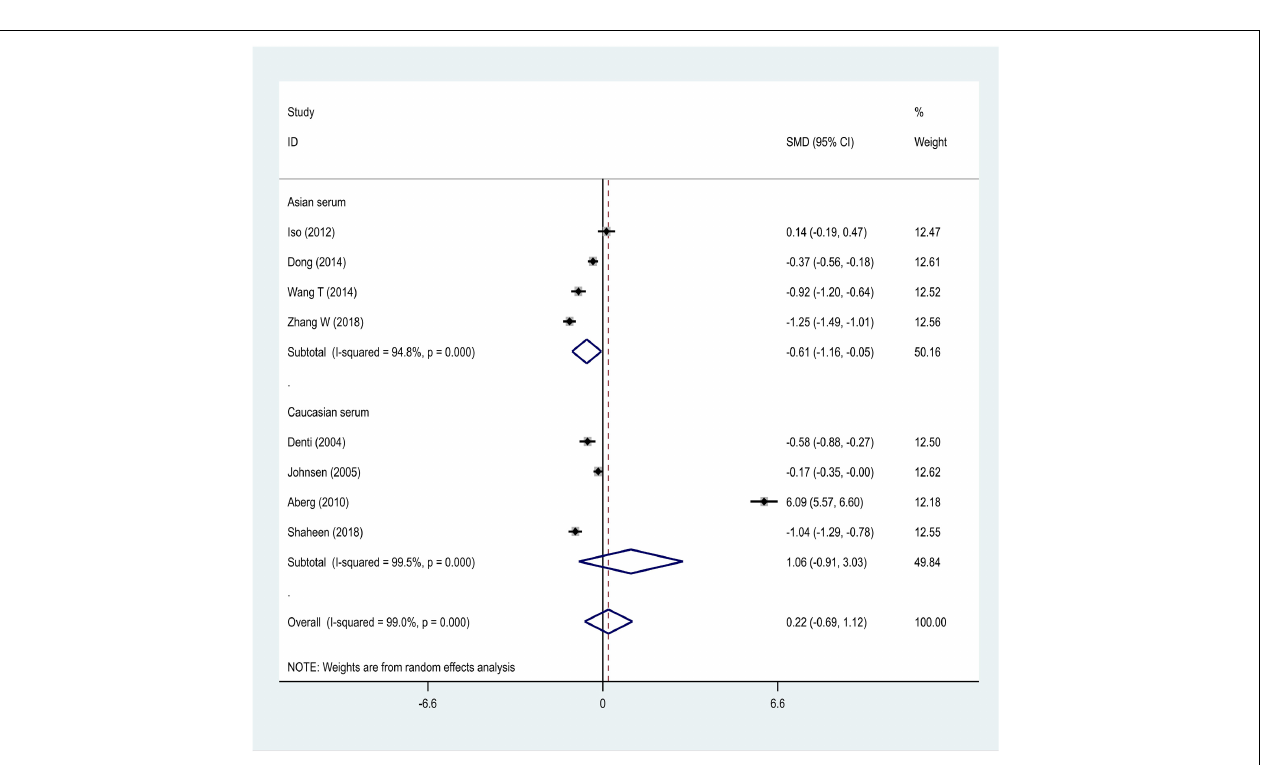
Frontiers in Aging Neuroscience |